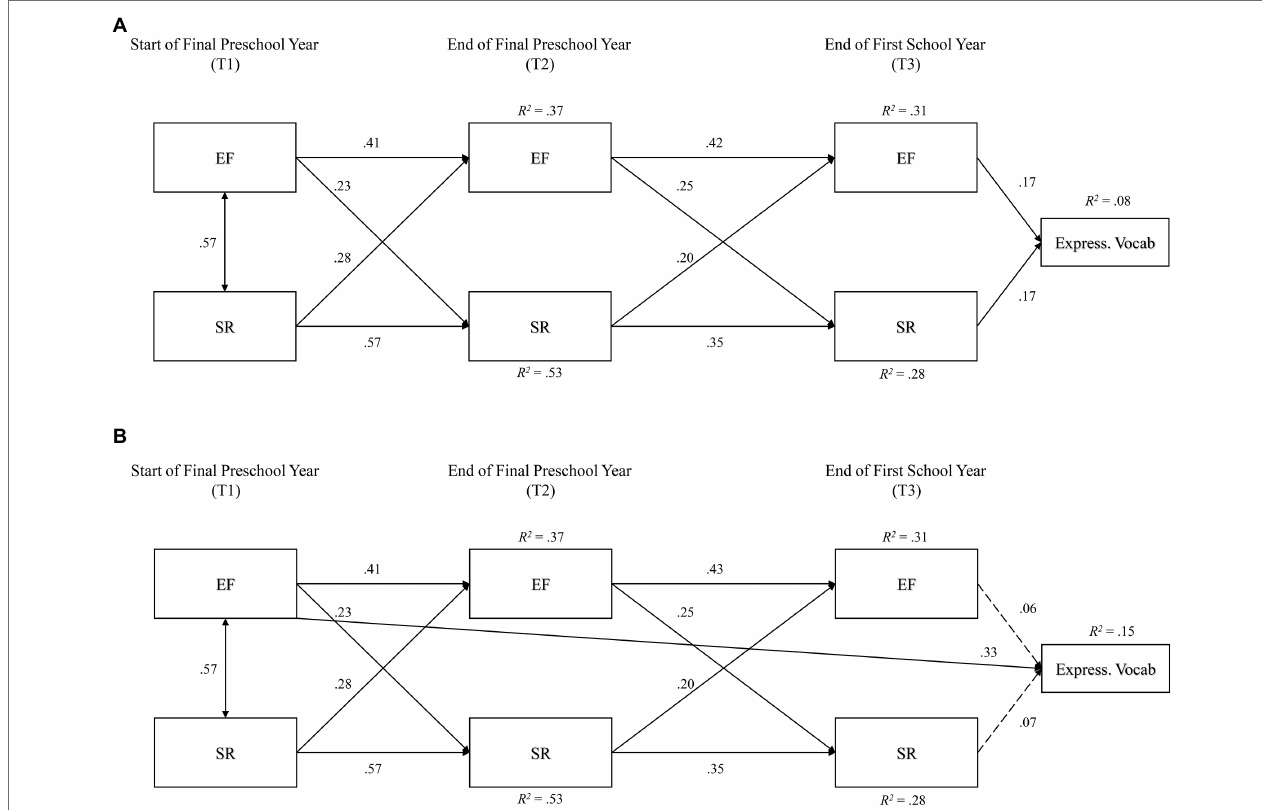
FIGURE 3 | Model 3: (A) cross-lagged panel model predicting vocabulary. Model 3: (B) cross-lagged panel model predicting vocabulary, with direct path from T 1 EF. Path loadings are standardized regression weights. Dashed lines are non-significant. Correlated error terms between T 2 and T 3 EF and SR were modelled but are omitted from this figure. EF, executive function composite index and SR, self-regulation composite